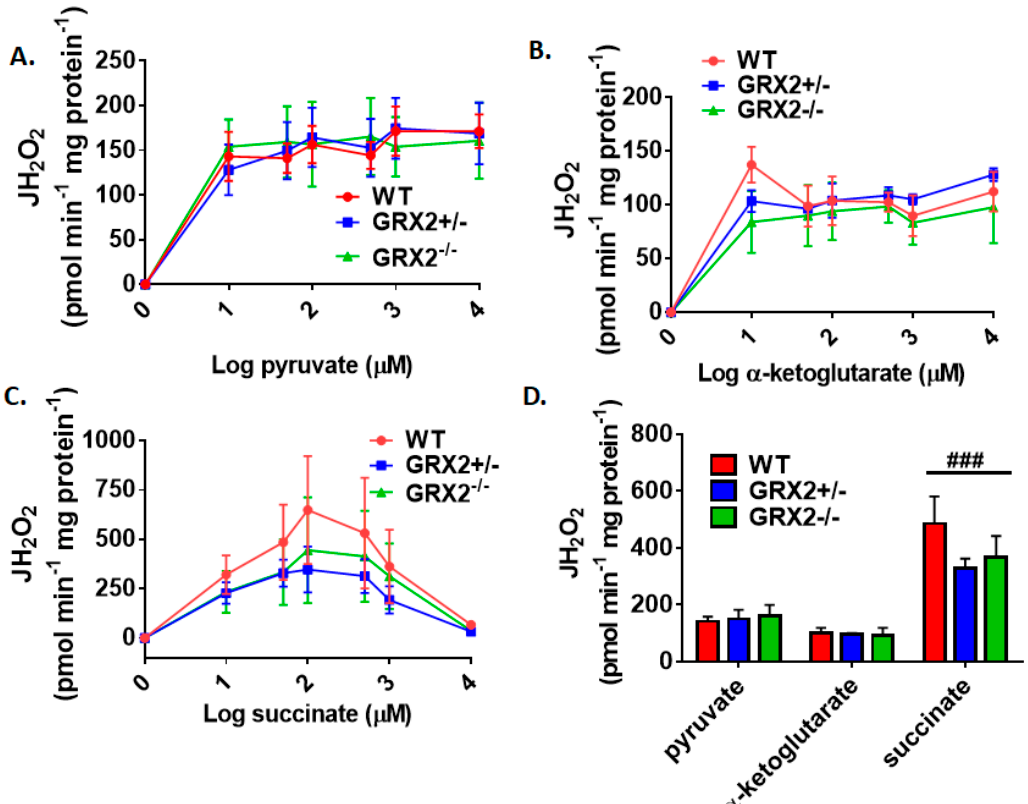
Figure 4. Deletion of the Grx2 gene does not alter the rate of H 2 O 2 production by muscle mitochondria isolated from female mice. Rates of production by mitochondria energized with pyruvate ( A ), α -ketoglutarate ( B ), or succinate ( C ) at a concentration range of 10–10,000 µ M. ( D ). Comparison of the rates of ROS production in mitochondria isolated from WT, GRX2 +/ − , and GRX2 − / − mice oxidizing 50 µ M pyruvate, α -ketoglutarate, or succinate. n = 4, mean ± SEM, 2-way ANOVA with a post-hoc Tukey’s test. ###: p ≤ 0.001